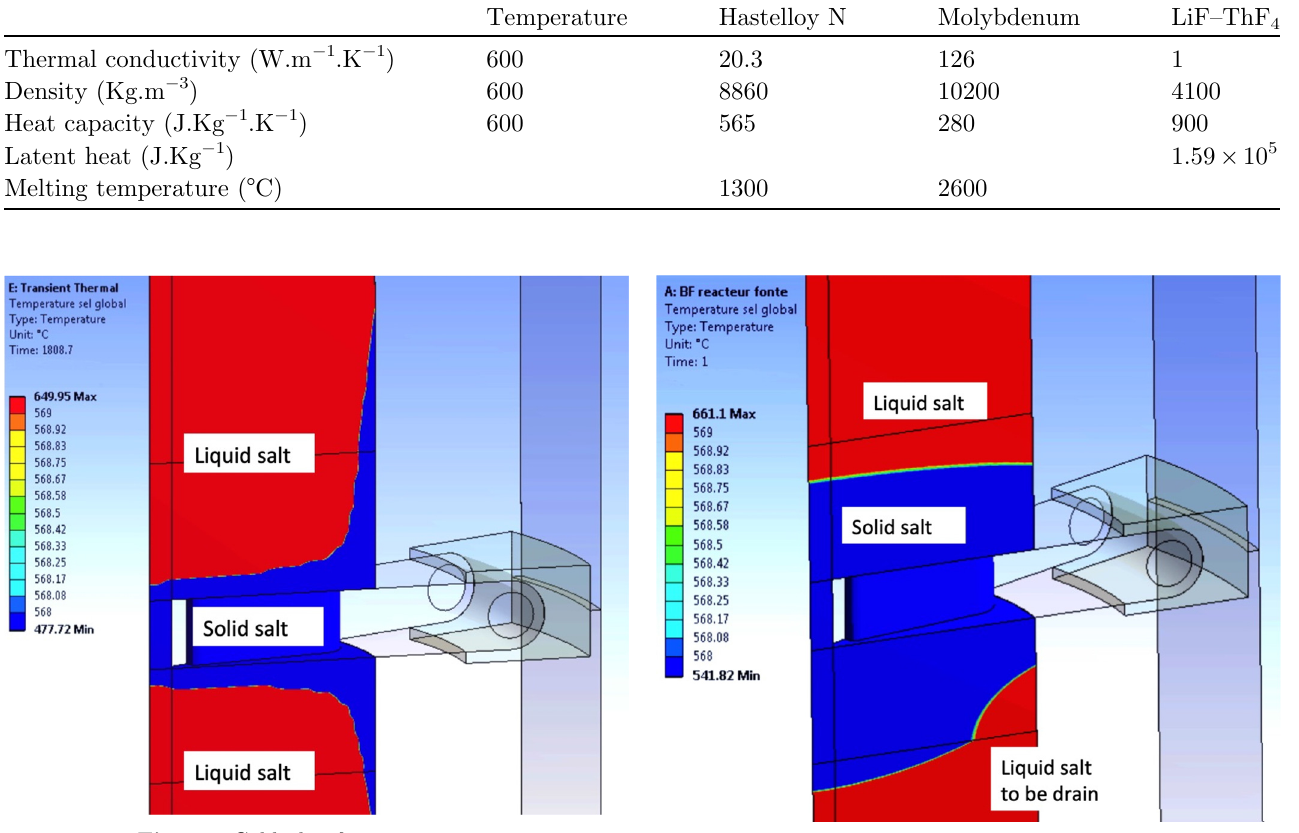
Fig. 16. Cold plug formation stage. Fig. 17. Closed cold Plug in normal operation.